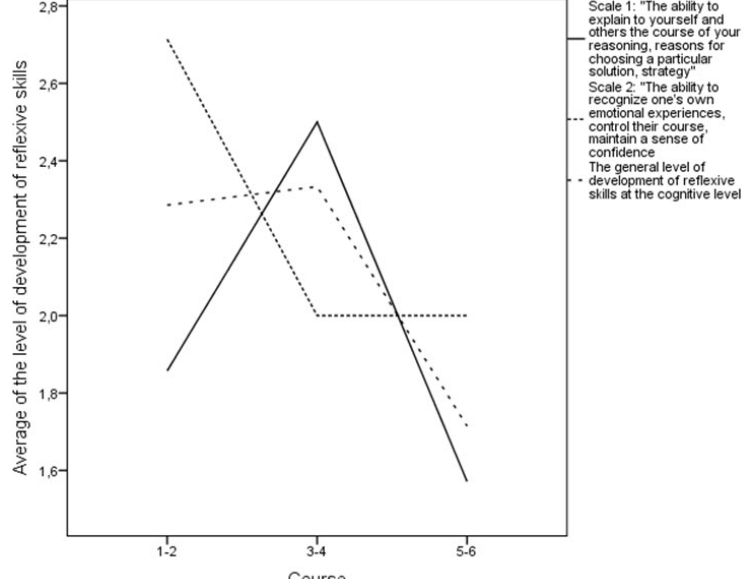
Figure 1. The results of the method “The reflexive skills (cognitive level)” (O. V. Savchenko) among students in accordance with the curriculum with the use of one-factor dispersion analysis of variance